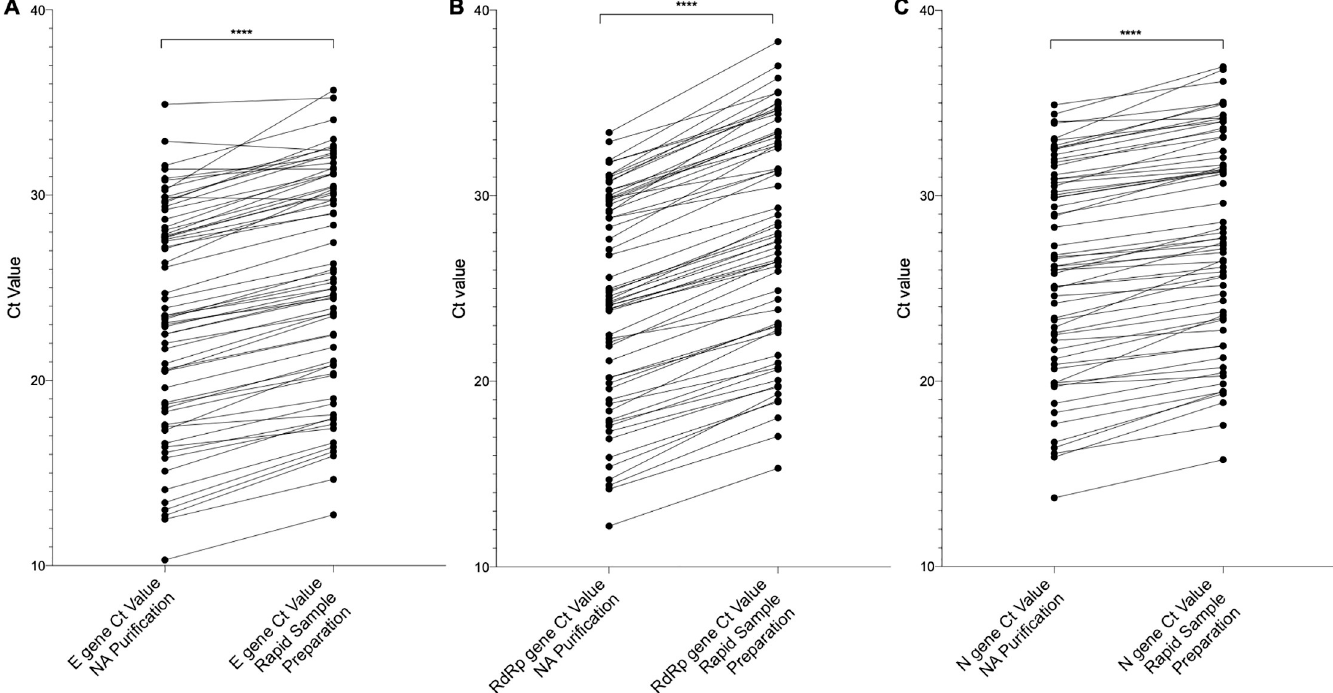
Fig 1. Comparison of target Ct values after RSP and NucliSENS 1 easyMag NA purification. The Ct values for the SARS-CoV-2 (A) Envelope (E), (B) RNA- dependent RNA-polymerase (RdRp) and (C) Nucleocapsid (N) gene targets are shown for samples tested with the Allplex ™ 2019-nCoV assay after NucliSENS 1 easyMag 1 NA purification and RSP. The difference in generated Ct values was found to be statistically significant in each case with a P value of < 0.0001 as determined by paired t-test.